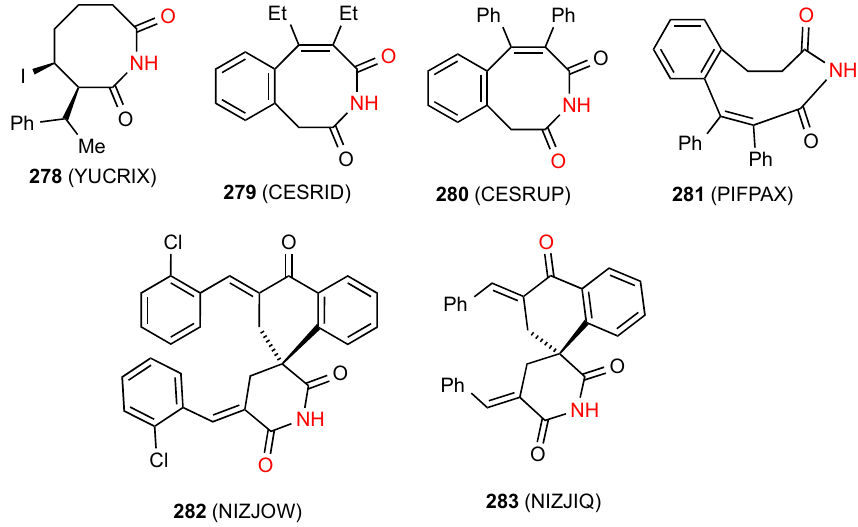
Figure 80. Eight- and nine-membered ring imides and spiro imides of patterns A and F.